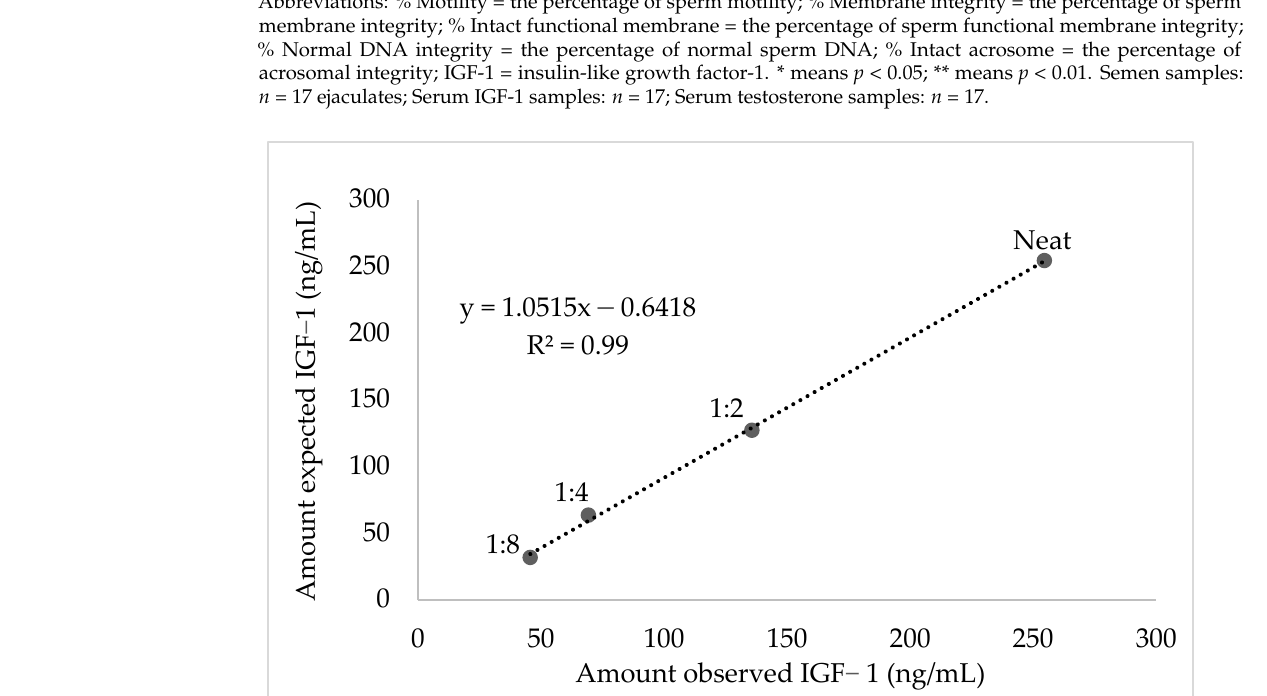
accurate linear detection of examined insulin − like growth factor − 1 (IGF − 1) concentrations. R 2 value